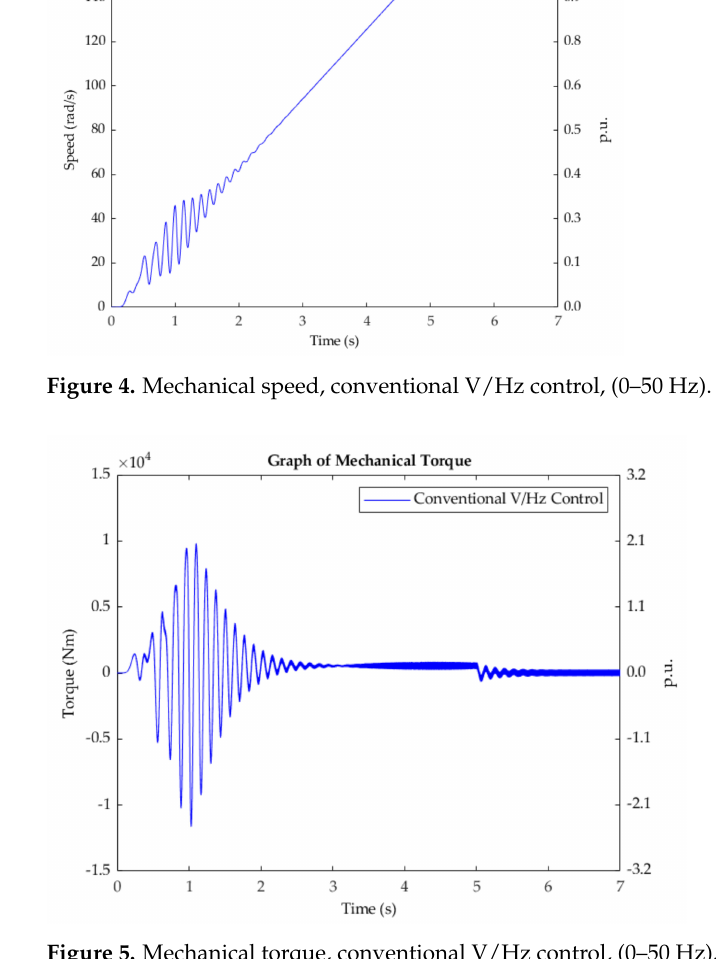
Figure 5. Mechanical torque, conventional V/Hz control, (0–50